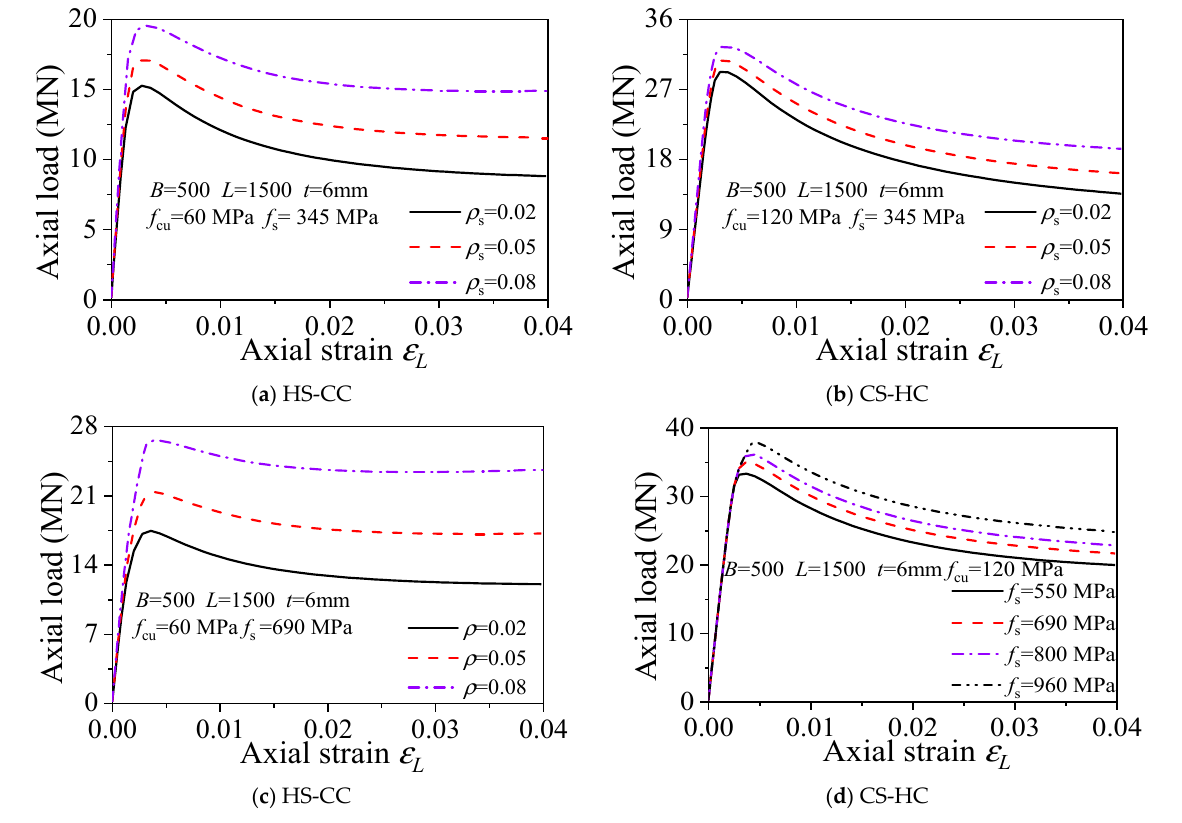
Figure 8. This is a figure. Schemes follow the same